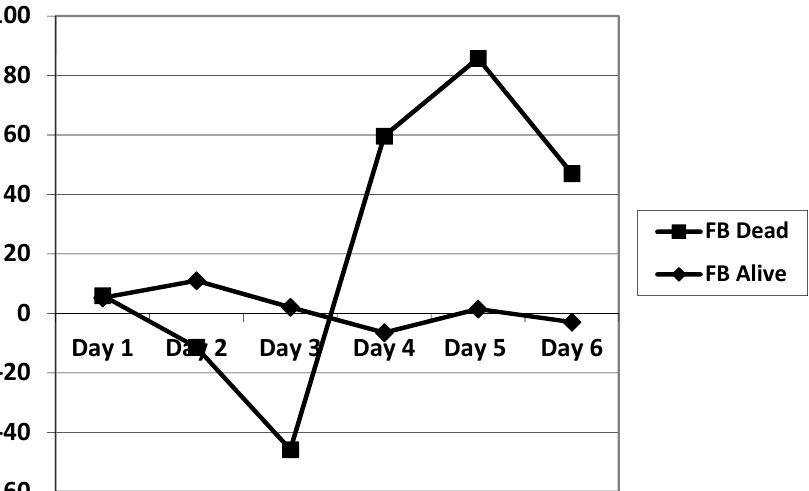
Figure 4. Comparison of the evolution of the fluid balance during the 7 days of ECMO between survivors and non-survivors. FB: fluid balance.